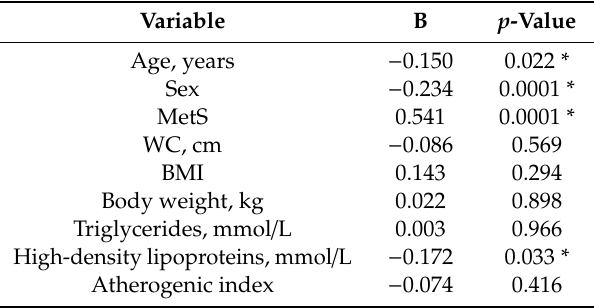
Table 5. Determinants of free triiodothyronine (FT3) concentrations in multiple regression analysis. Variable Β p -Value Age, years